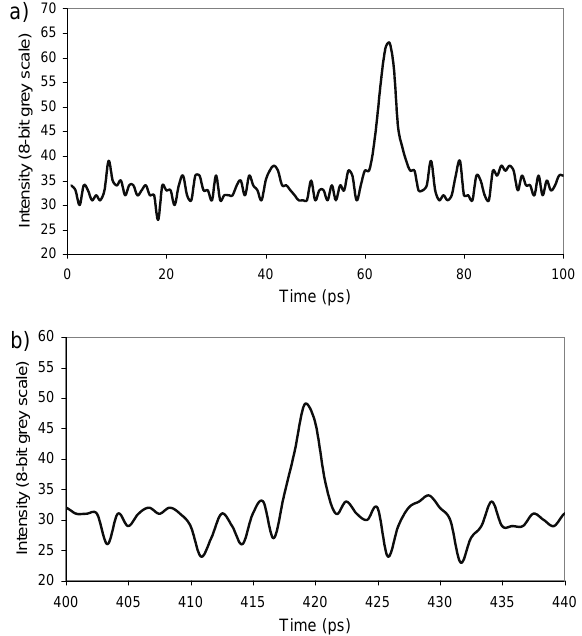
FIG. 16. Streak camera image line outs. (a) The reflection of the laser beam off the photocathode with no rf in the gun (and therefore no photoelectron beam and emission produced). The 2 ps length demonstrates the camera resolution. (b) Emission from the photoelectron beam with the laser blocked by a filter, showing the duration to be at or below the camera resolution (2